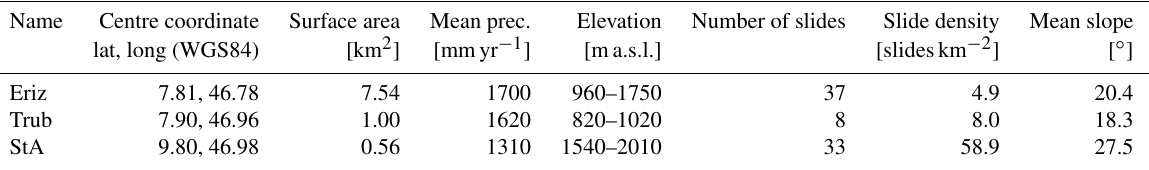
Table 2. Study area characteristics. Meteorological data are from the HADES yearly average precipitation for the time period 1981–2010 (Frei et al., 2020). Shallow-landslide number and density are from the inventory in Sect. 3.3.